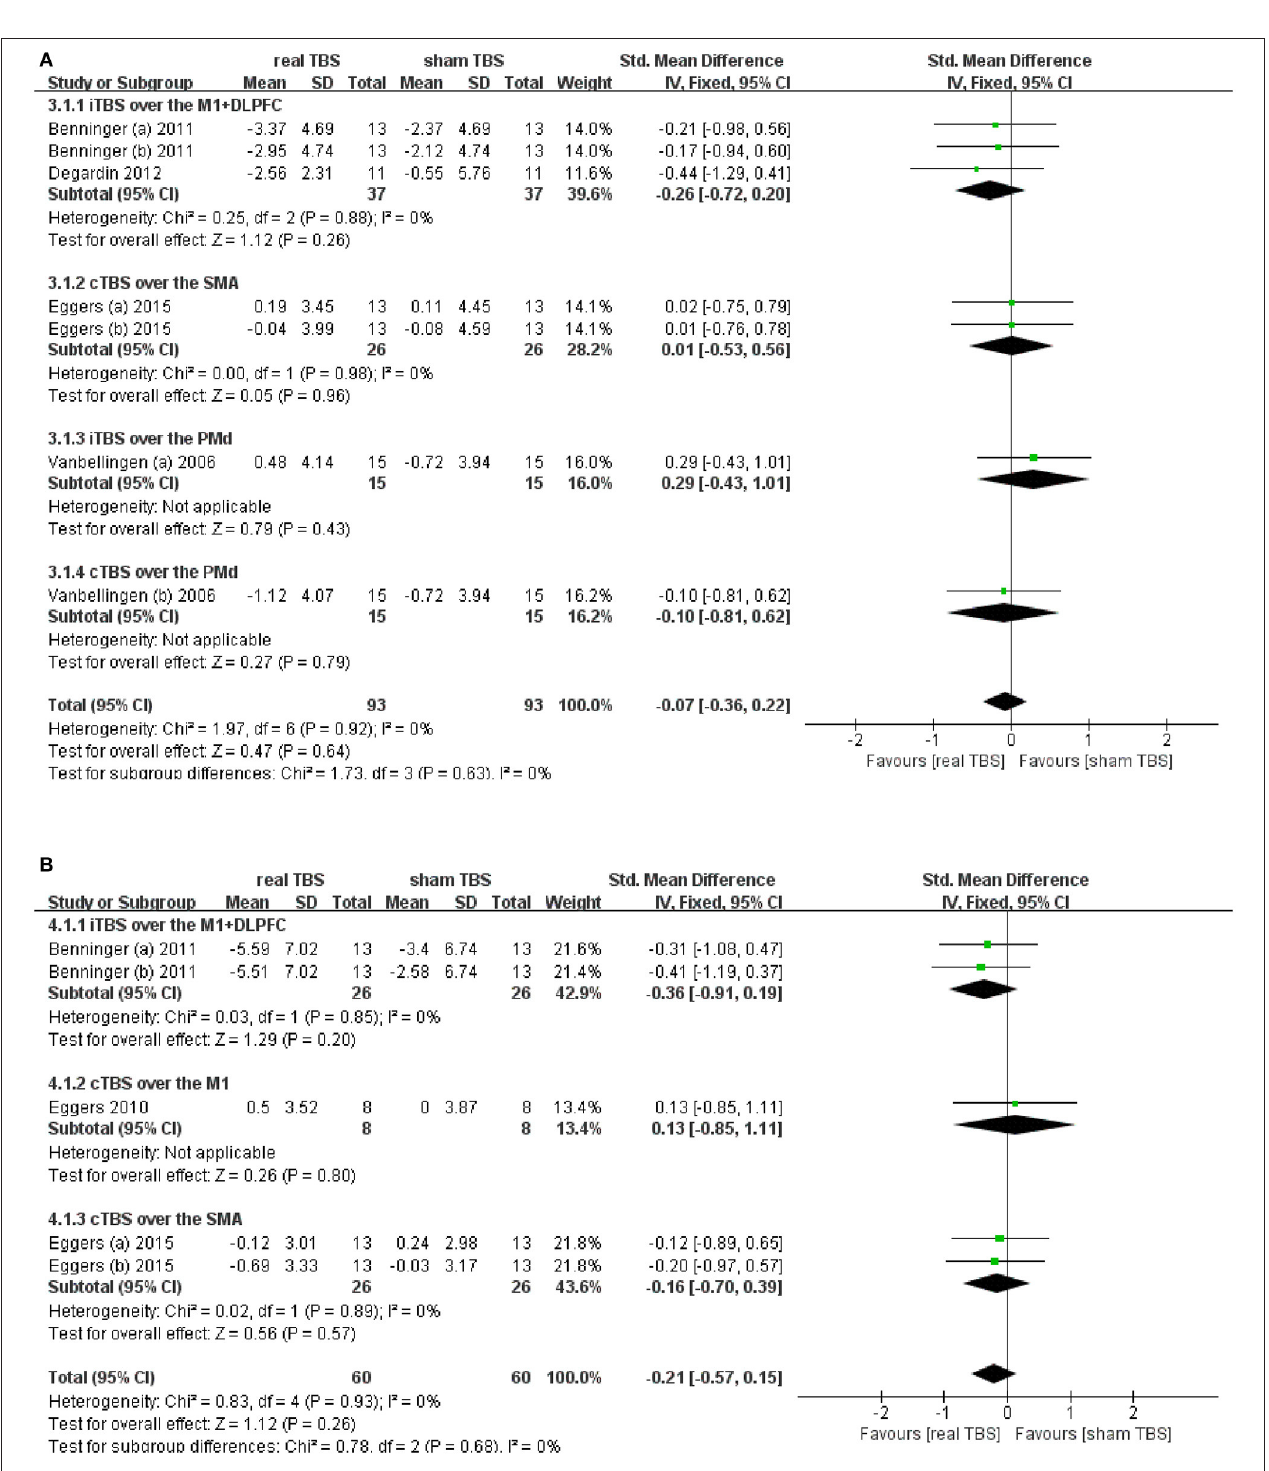
FIGURE 3 | (A) Forest plot and metaanalysis of upper limb movement between real TBS and sham TBS in the “on” medicine state: subgroup analysis based on iTBS/cTBS-brain targets. (B) Forest plot and metaanalysis of upper limb movement between real TBS and sham TBS in the “off” medicine state: subgroup analysis based on iTBS/cTBS-brain